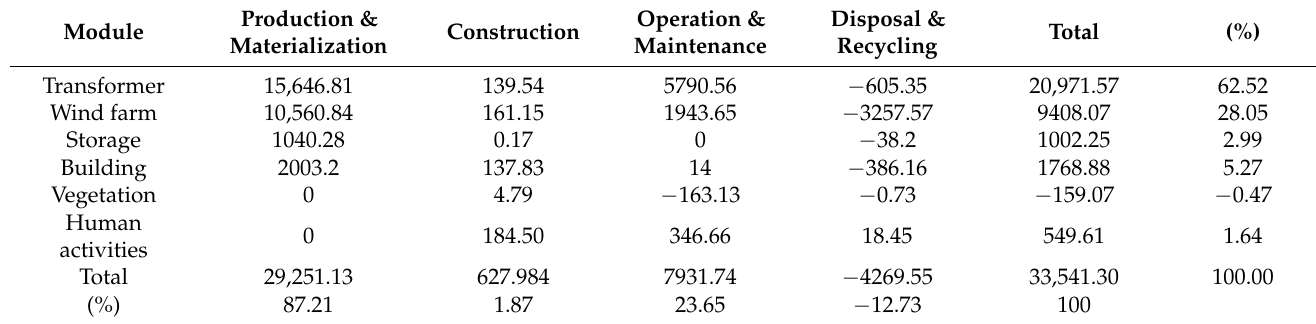
Table 11. Carbon emissions (t) in each phase and module in LCA.